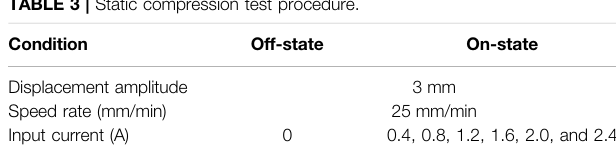
TABLE 3 | Static compression test procedure.